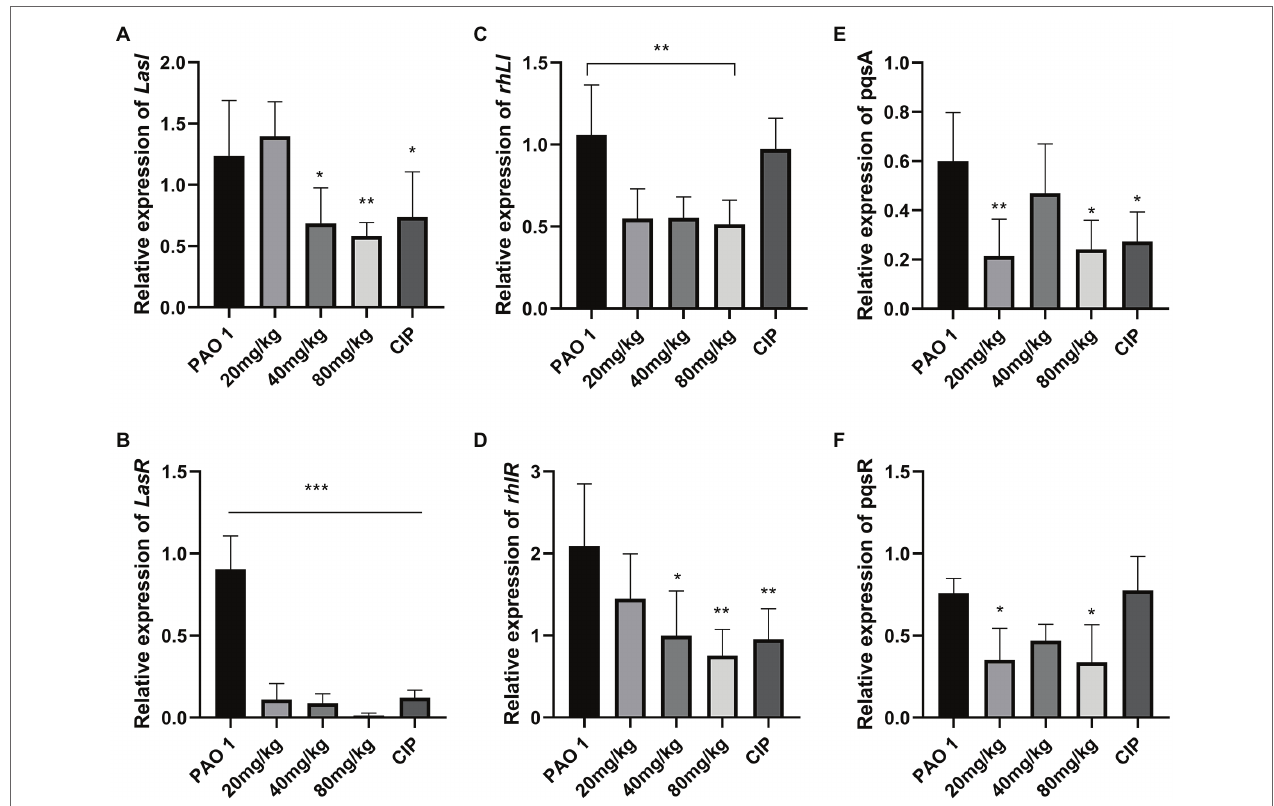
FIGURE 2 | The effect of EGCG on the expression of QS system in vivo . (A) lasI , (B) lasR , (C) rhlI , (D) rhlR , (E) pqsA , and (F) pqsR . Data are presented as mean ± SD and analyzed with one-way ANOVA. * p < 0.05, ** p < 0.01, *** p < 0.005 vs. PAO 1